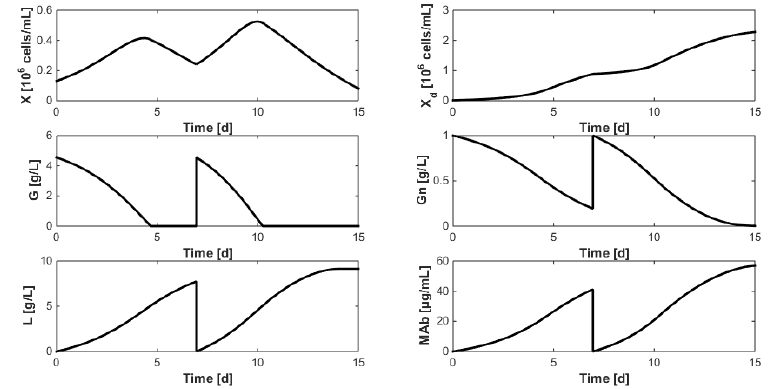
Figure 11. Optimization of the renewal time when an important substrate saving (α = 10) to maximize the produced monoclonal antibody amount.